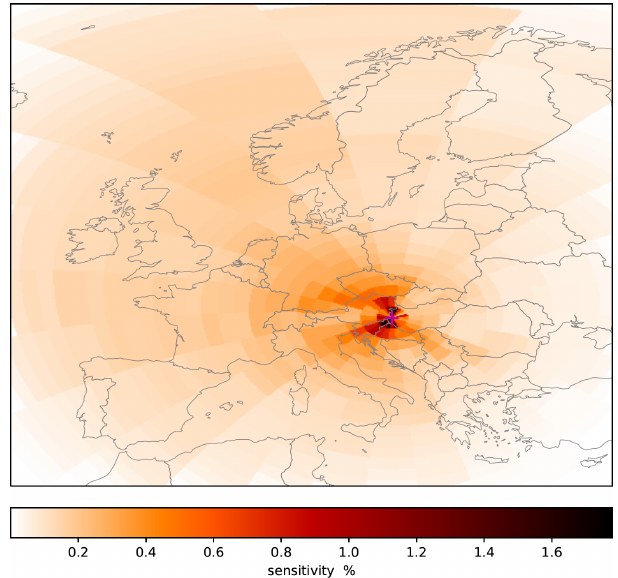
Figure 7. Footprint climatology of the concentration measurements performed at 115m elevation above the ground in 2019 calculated by the STILT model (Carbon Portal ICOS RI,